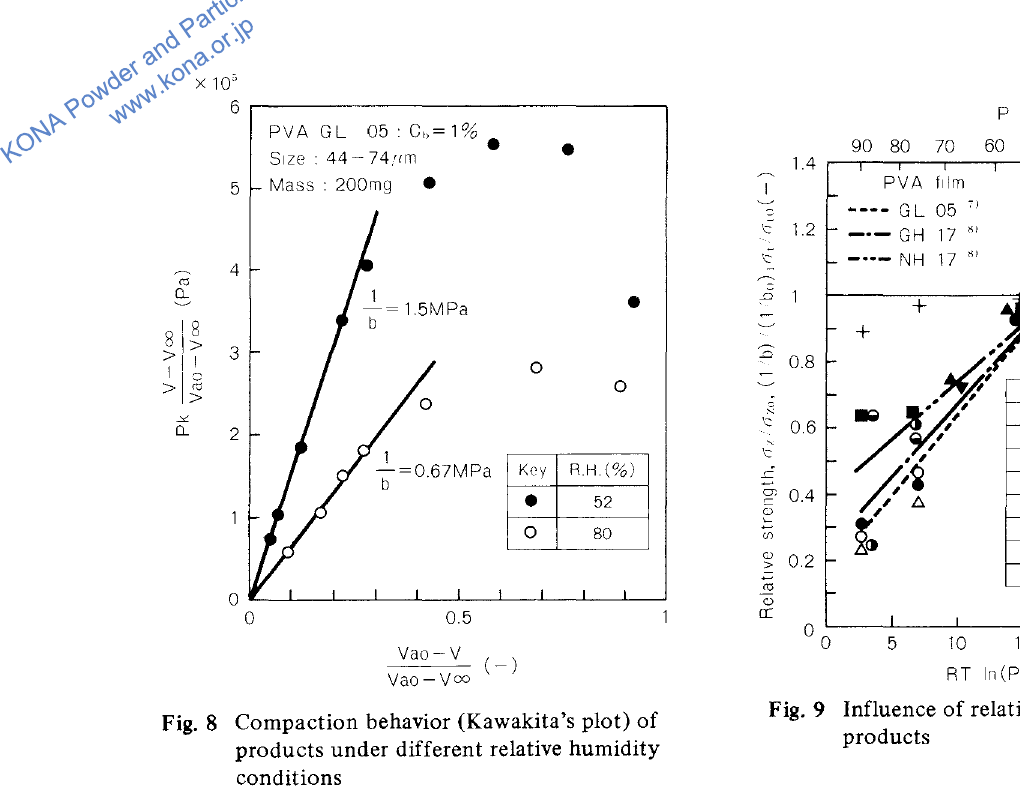
Fig. 8 Compaction behavior (Kawakita's plot) of products under different relative humidity conditions